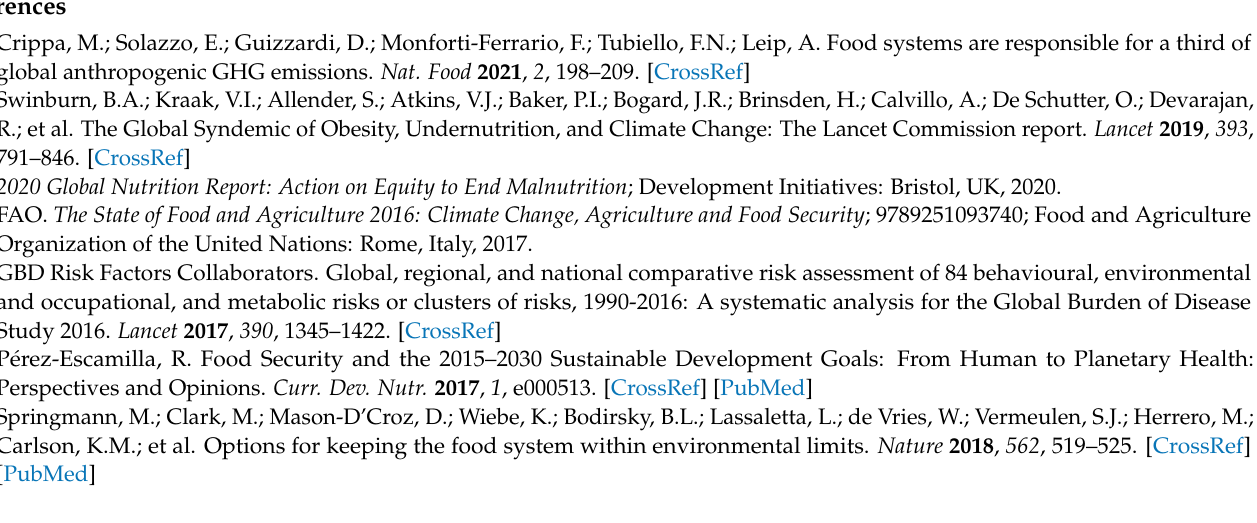
Table S2: Total GHGE per year in Kg of CO2e of school food menus according to the age group and percentage of menus being sustainable. Table S3: List of ingredients and per capita amount of conventional and sustainable school food